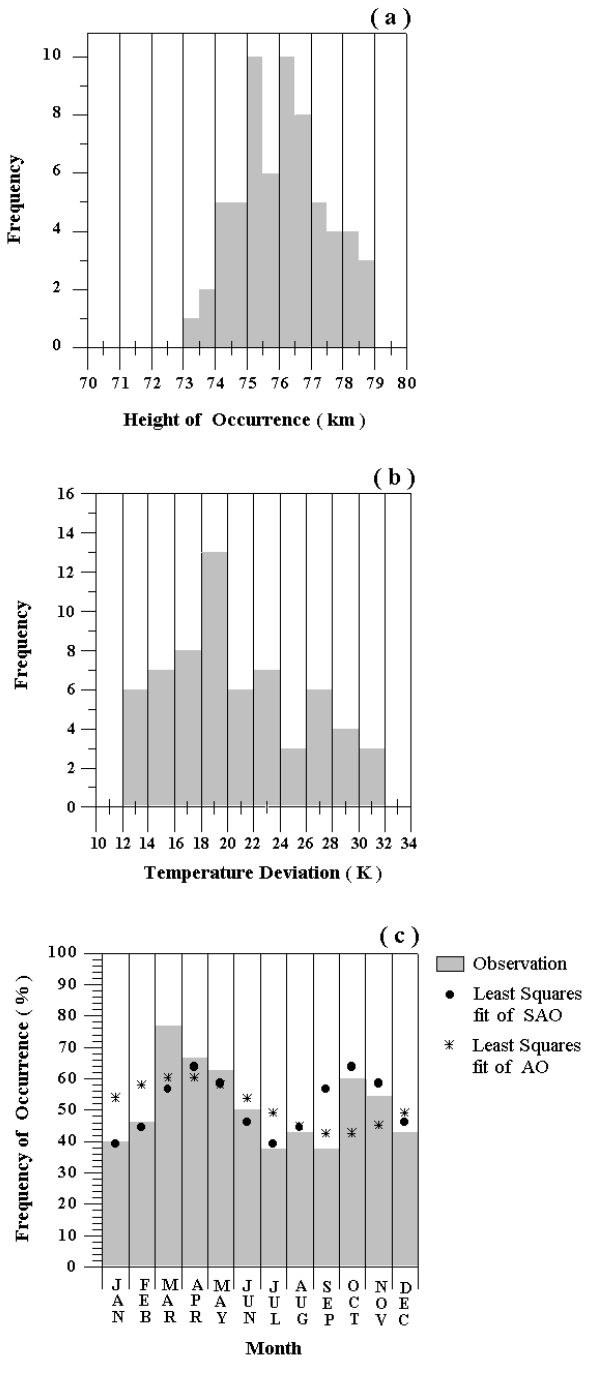
Fig. 3. Mesospheric temperature inversion frequency distributions for (a) height of occurrence, (b) temperature deviation, and (c) monthly percentage